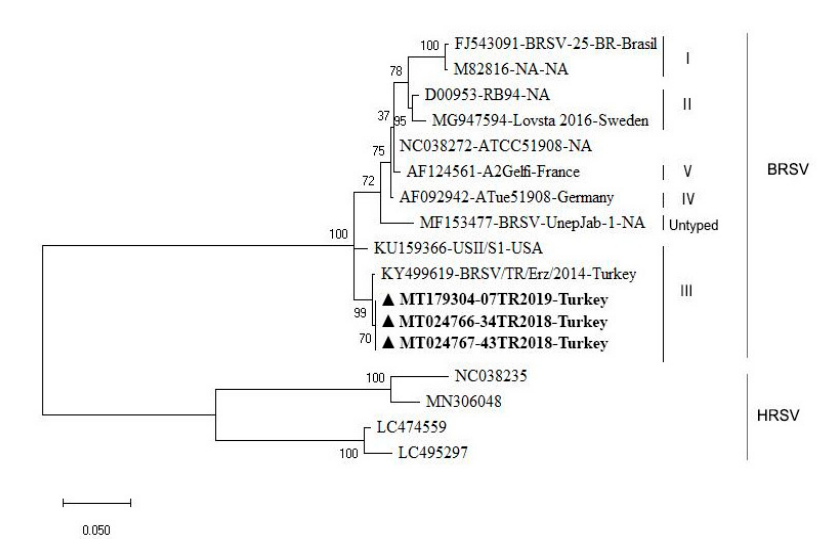
Figure 2. The phylogenetic analysis of the BRSV strains isolated in this study. The tree was constructed from a partial analysis of the BRSV F gene using the maximum likelihood method with MEGA X software. The robustness branching pattern was tested with 1000 bootstrap replications. According to the phylogenetic tree, the current strains were in subgroup III (marked in bold and with a ▲ ). The BRSV sequences were named using their GenBank accession number, strain name, and geographical origin. NA: Not available.